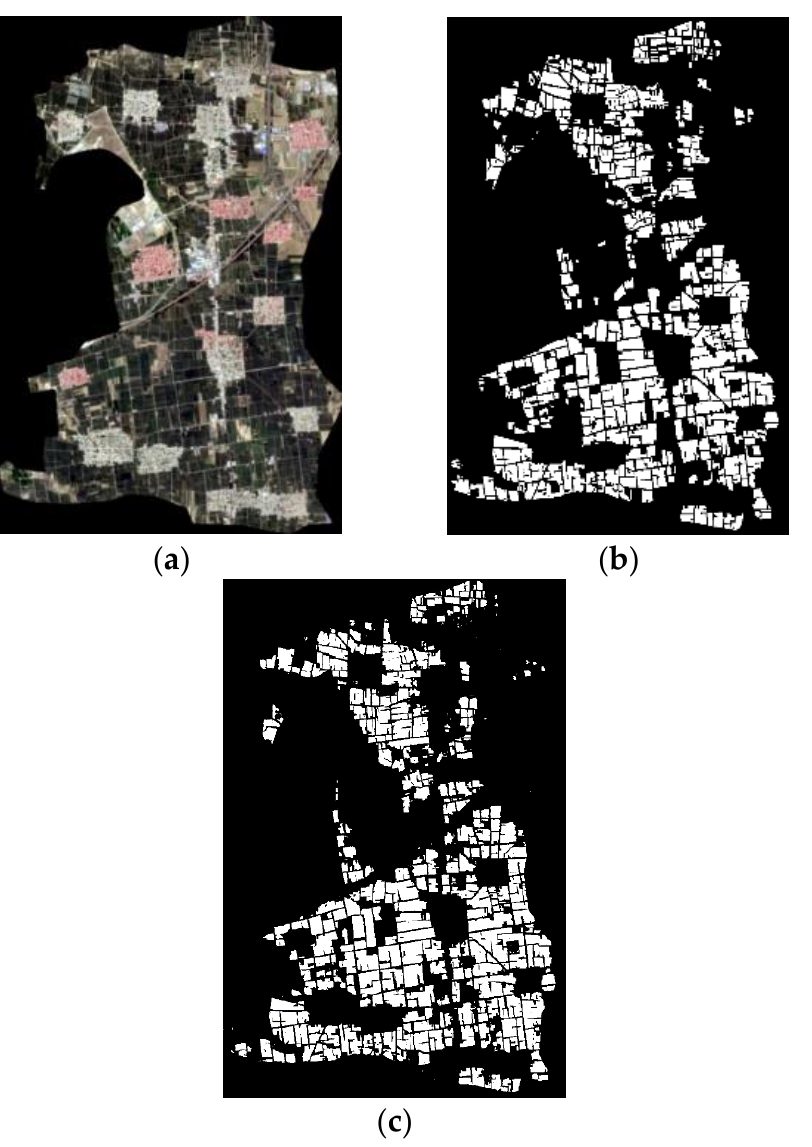
Figure 6. Mapping winter-wheat planting areas in Zengcun County: ( a ) Sentinel-2 original image, ( b ) label, ( c ) U-Net-CBAM prediction results using the Sentinel-2A dataset as training dataset.